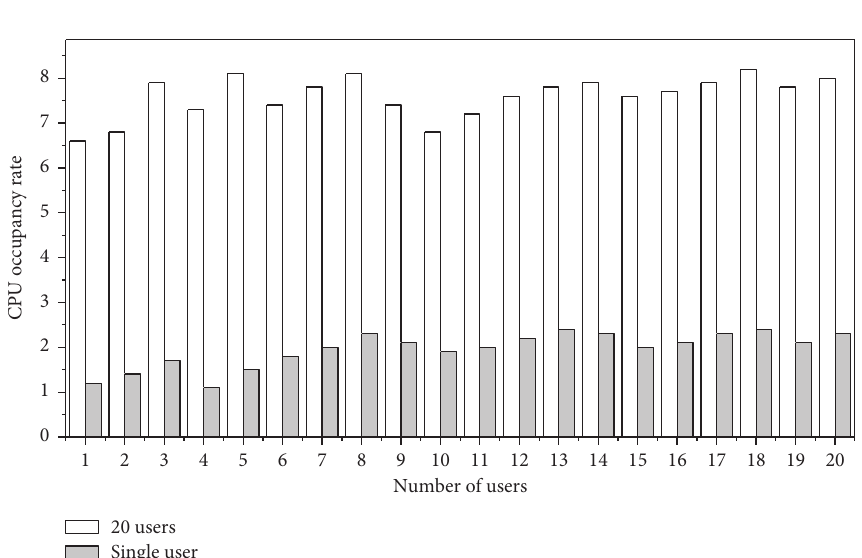
Figure 10: CPU usage of the system